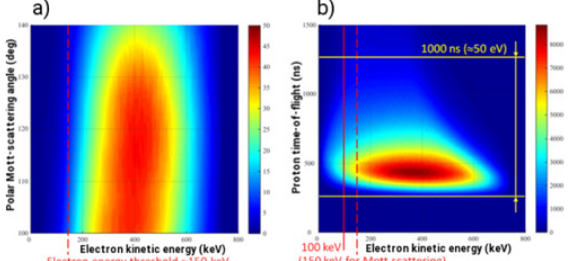
Figure 4. Figure-of-Merit (arbitrary units) for the spin analysis in backward angle Mott scattering on a 2 µ m thick Pb target. b) Population of the neutron decay phase space projected onto the proton time-of-flight vs. electron kinetic energy E kin